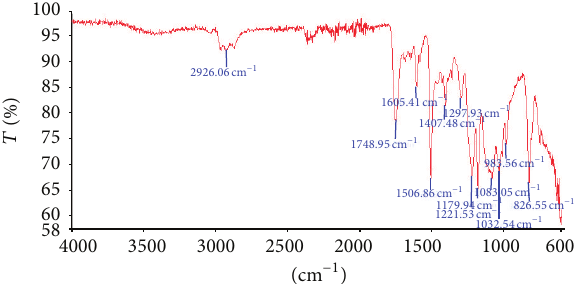
Figure 4: ATR-FTIR spectrum of the coating system before expo- sure.